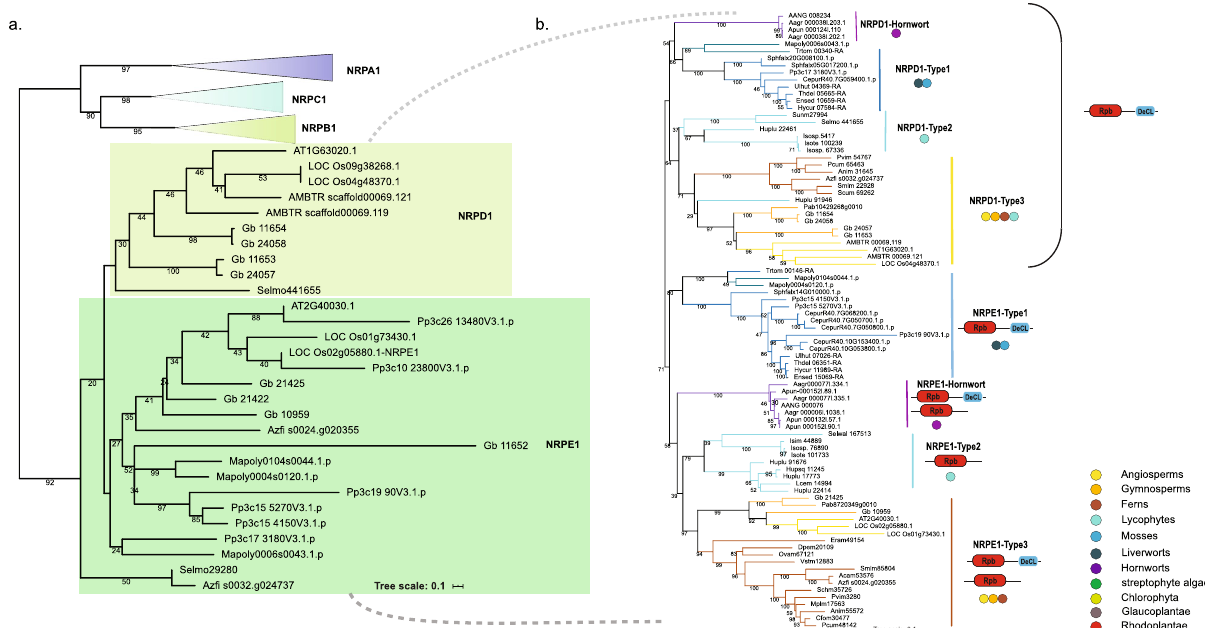
Fig. 4 Phylogenetic trees of subunit 1 of RNA polymerase. a A maximum likelihood tree for subunit 1 of RNA polymerase in selected Viridiplantae species. b A maximum likelihood tree of subunit 1 of RNA polymerase using an extended taxon sampling of bryophytes. The domain information is displayed for each group. The tree was constructed by maximum likelihood using 500 bootstrap replicates, values ≥ 30% are shown on internal branches. The PROTCATGTR model was predicted by Model fi nder. For species designations of sequence IDs, see Supplementary data